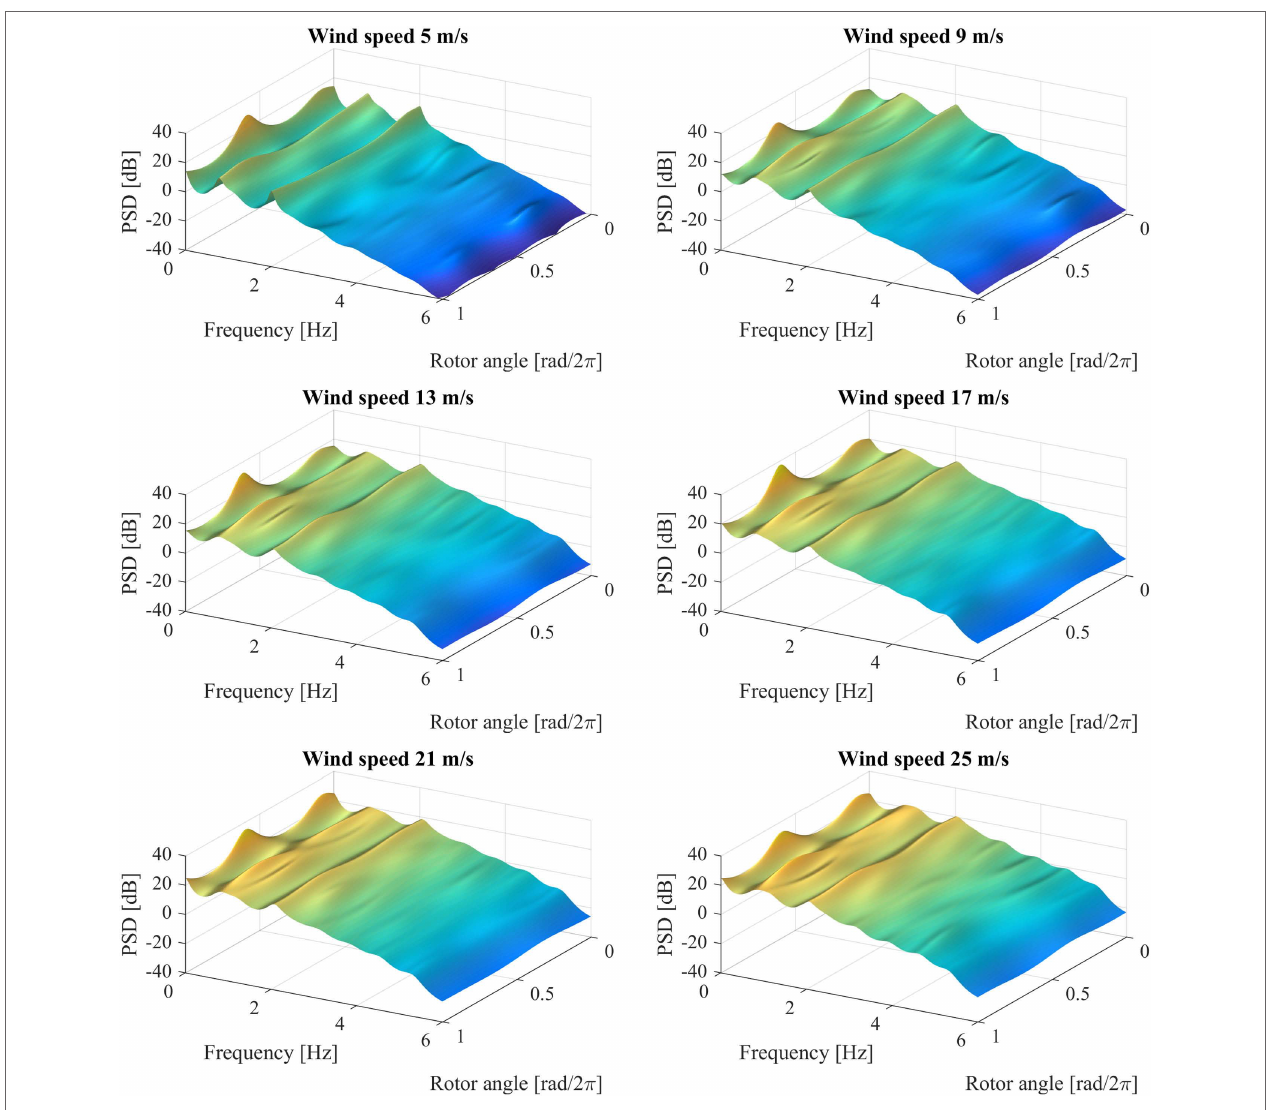
FIGURE 11 | GP-LPV-AR model-based “frozen” Power Spectral Density evaluated for a full rotation period of the wind turbine blade, and for increasing wind speeds.